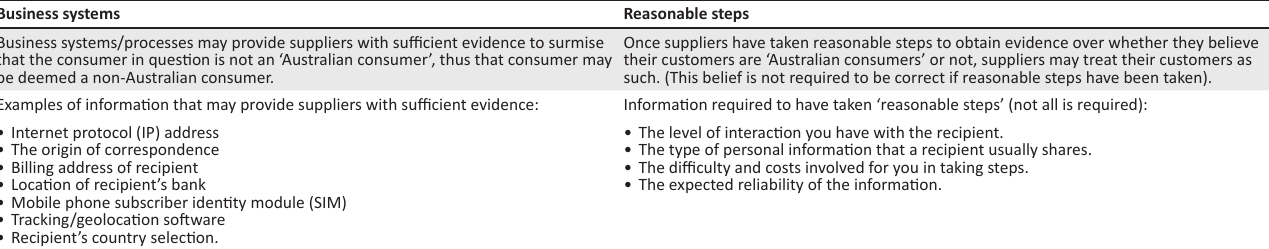
TABLE 2: Australia’s safe harbour